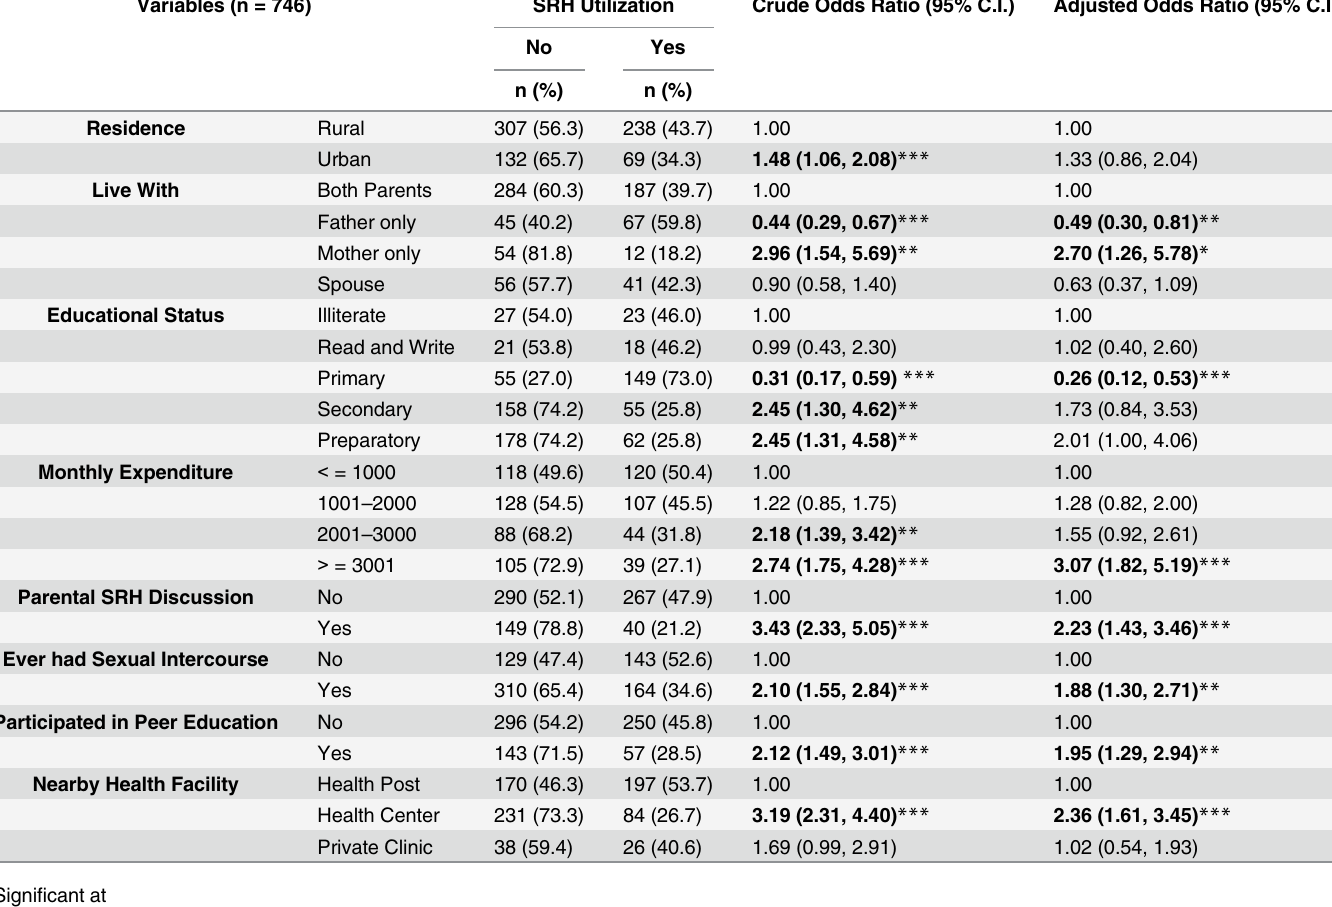
Table 2. Factors associated with SRH service utilization among young people in Northwest Ethiopia,